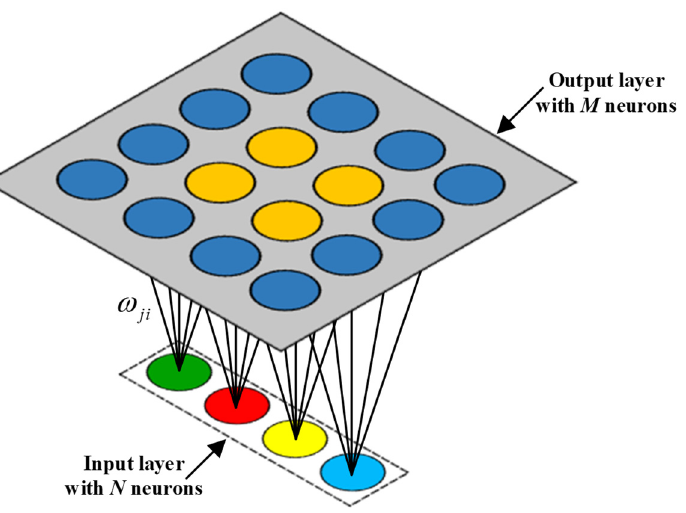
Figure 1. Schematic representation of a SOM structure, its construction and the two main characteristic layers.